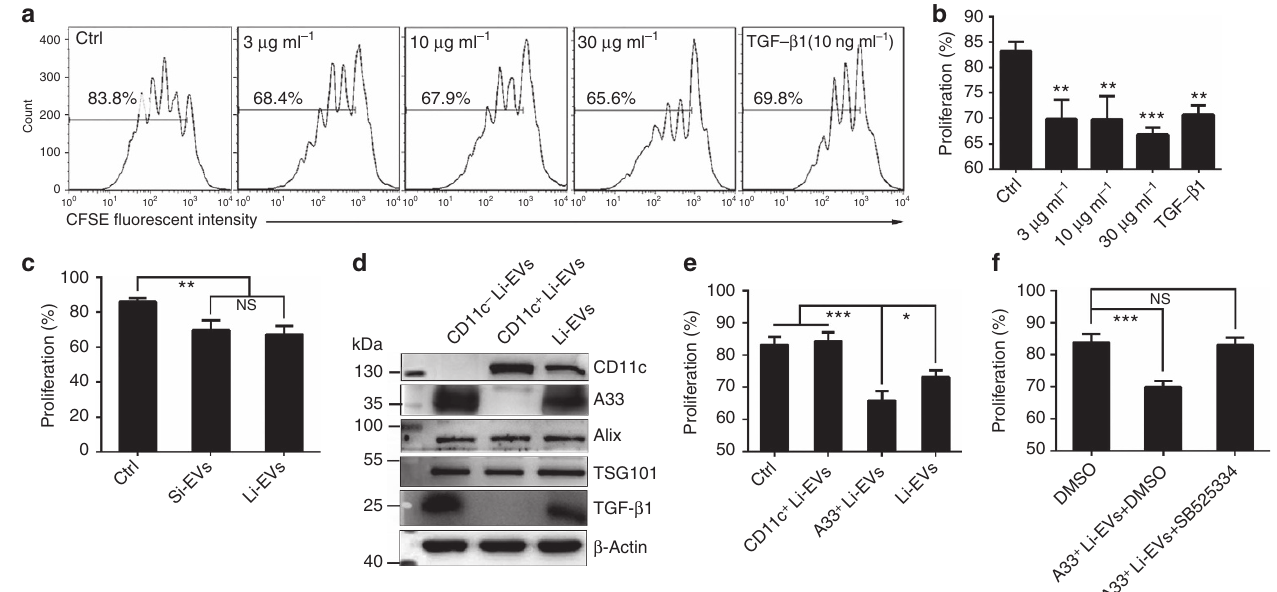
Figure 2 | Li-EVs from IECs inhibit CD4 þ T-cell proliferation in vitro . ( a ) Overall, 1 (cid:3) 10 6 ml (cid:2) 1 carboxyfluorescein succinimidyl ester (CFSE)-labelled CD4 þ Tcells were seeded into 96-well plate and proliferation of Tcells was elicited by 1 m l anti-CD3/CD28-coated beads. The indicated concentration of Li-EVs was added. TGF- b 1 (10ngml (cid:2) 1 ) was added as a positive control. After culture for 3 days, proliferation of CD4 þ Tcells was analysed using FACS. ( b ) The data in a were statistically analysed ( n ¼ 9). ( c ) The proliferation assay described in a was performed in the presence of 30 m gml (cid:2) 1 Si-EVs or Li- EVs. The proliferation of CD4 þ Tcells was statistically analysed ( n ¼ 9). ( d ) CD11c þ and CD11c (cid:2) Li-EVs were isolated by CD11c þ magnetic beads. CD11c, A33, Alix, TSG101, TGF- b 1 and b -Actin in CD11c þ , CD11c (cid:2) and total Li-EVs were detected by western blot analysis. ( e ) The proliferation assay described in a was performed in the presence of 30 m gml (cid:2) 1 CD11c þ , A33 þ and total Li-EVs. The proliferation of CD4 þ Tcells was statistically analysed ( n ¼ 9). ( f ) The proliferation assay described in a was performed in the presence of 30 m gml (cid:2) 1 A33 þ Li-EVs with or without 0.5 m gml (cid:2) 1 TGF- b 1 signalling inhibitor (SB525334). The proliferation of CD4 þ Tcells was statistically analysed ( n ¼ 9). Data are representative of three independent experiments or are shown as mean values ± s.e.m. pooled from three independent experiments. P values were generated by one-way analysis of variance (ANOVA), followed